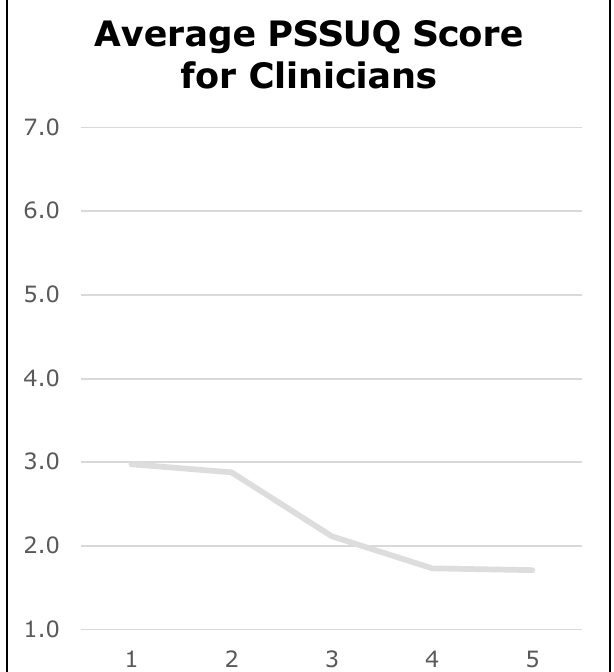
Figure 3. Average PSSUQ scores (average across PSSUQ items for each participant, then averaged across participants) for rehabilitation professionals across five rounds of